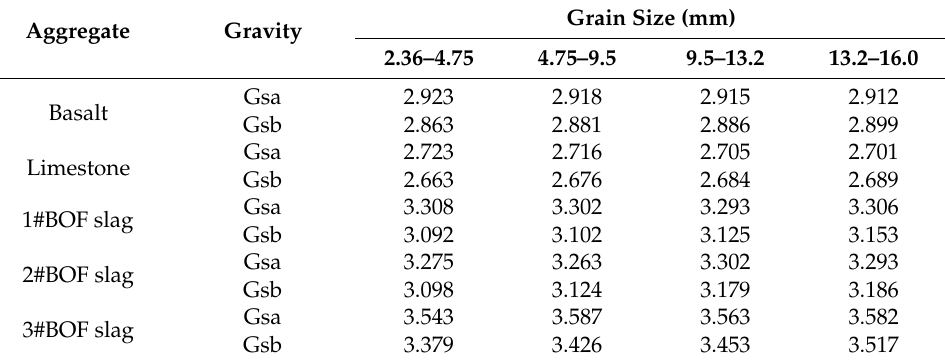
Table 5. Specific gravities of coarse aggregates at different size ranges.